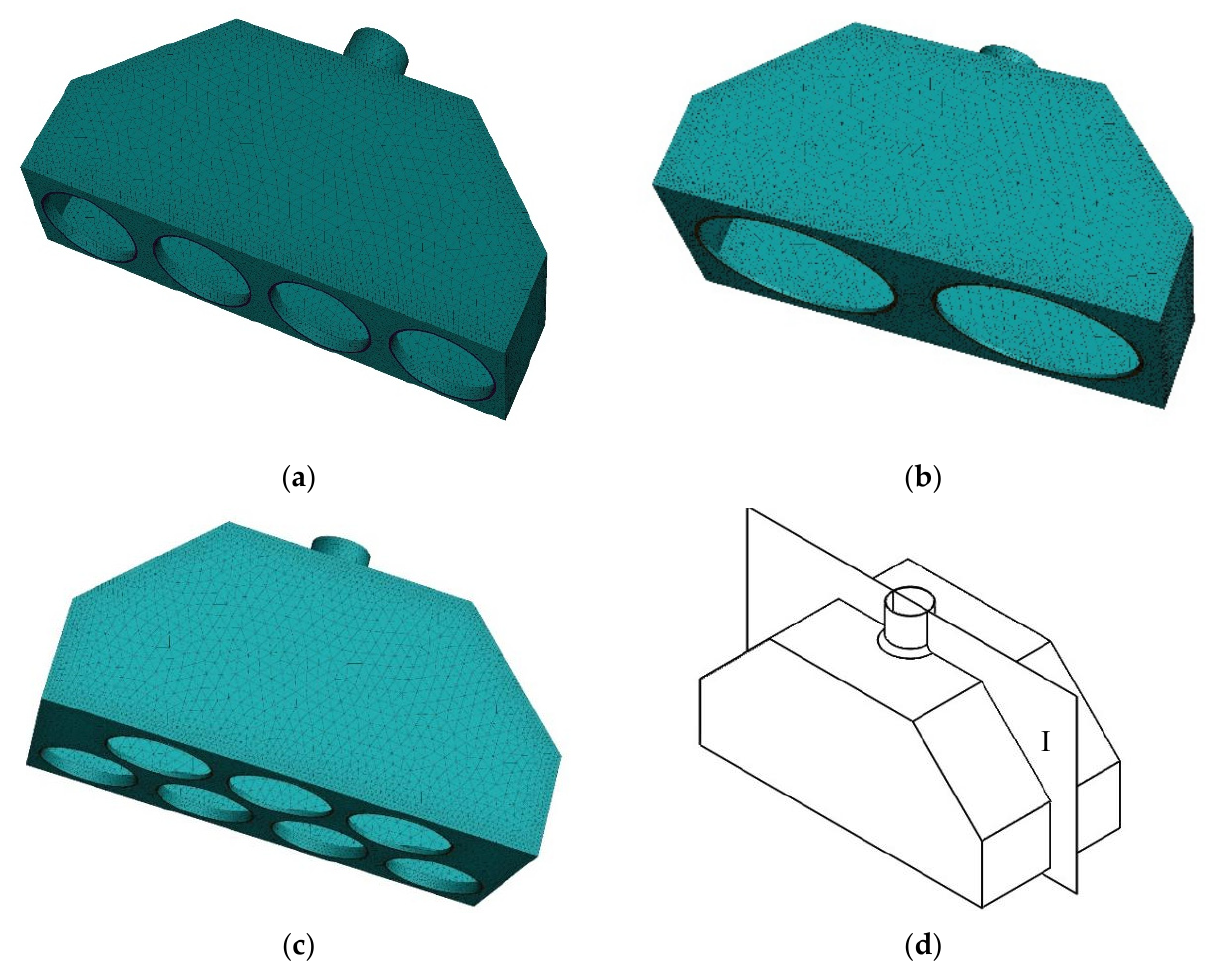
Figure 7. Grid division of collection device model. ( a ) Grid division of the collection hood for the first type of fan layout, ( b ) Grid division of the collection hood for the second type of fan layout, ( c ) Grid division of the collection hood for the third type of fan layout, ( d ) Cross section schematic diagram of velocity cloud map.